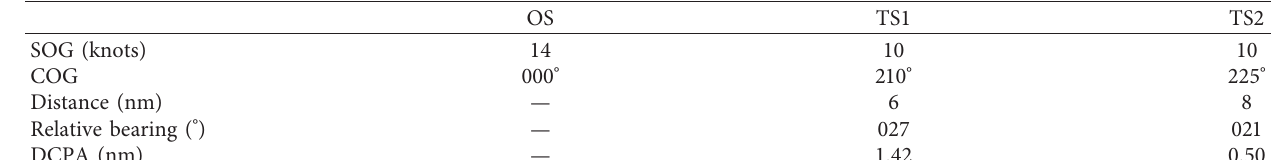
Table 3: Scenario II: initial encounter information.